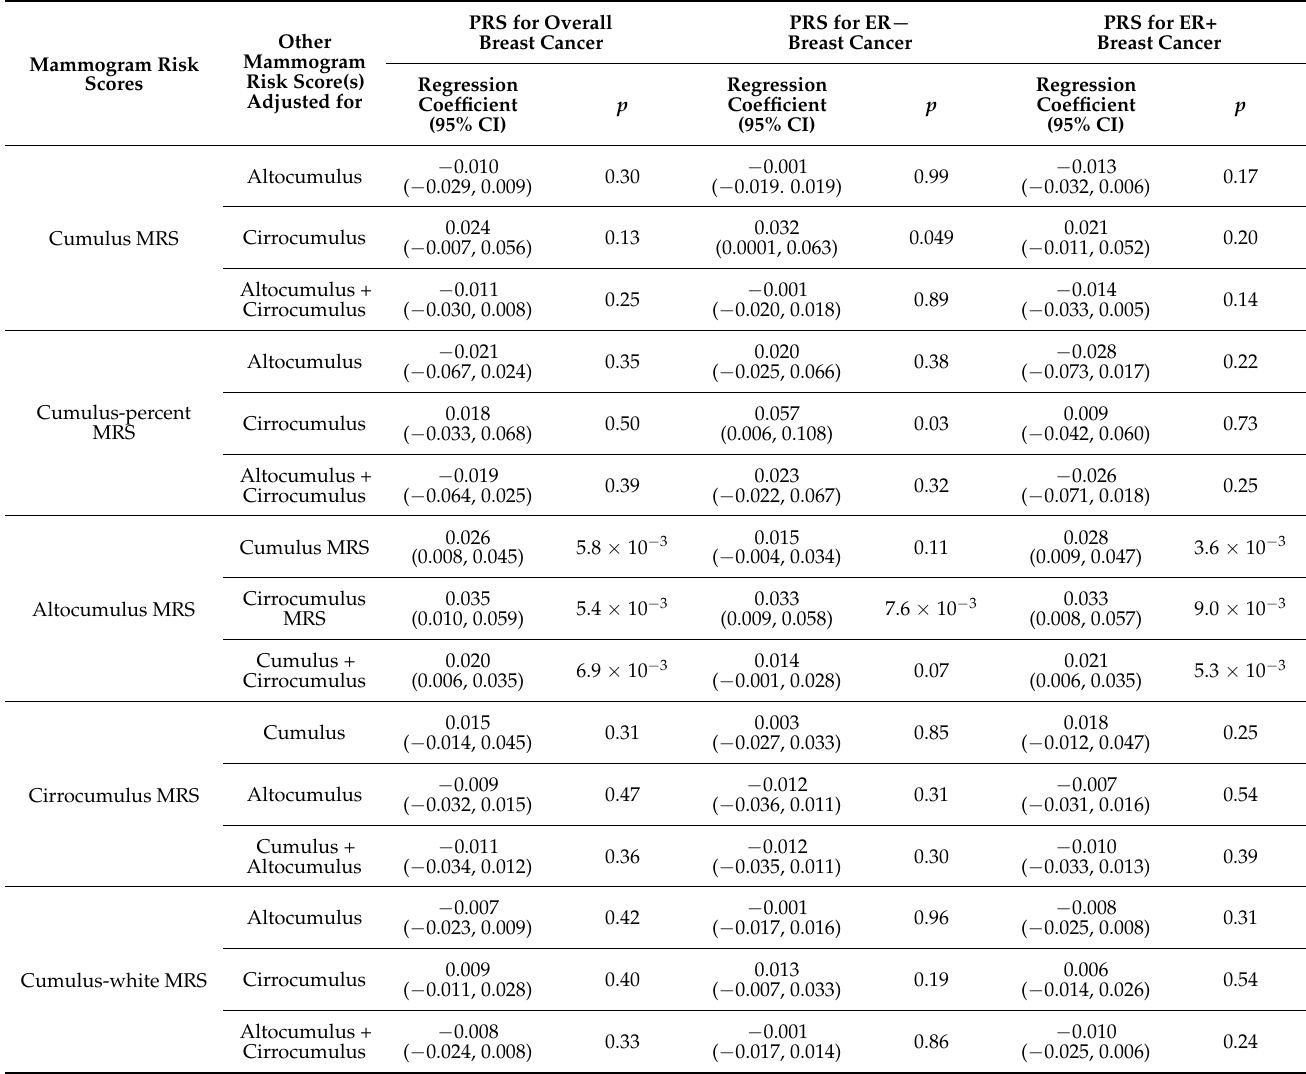
Table 4. Associations between mammogram risk scores and breast cancer polygenic risk scores adjusting for other mammogram risk